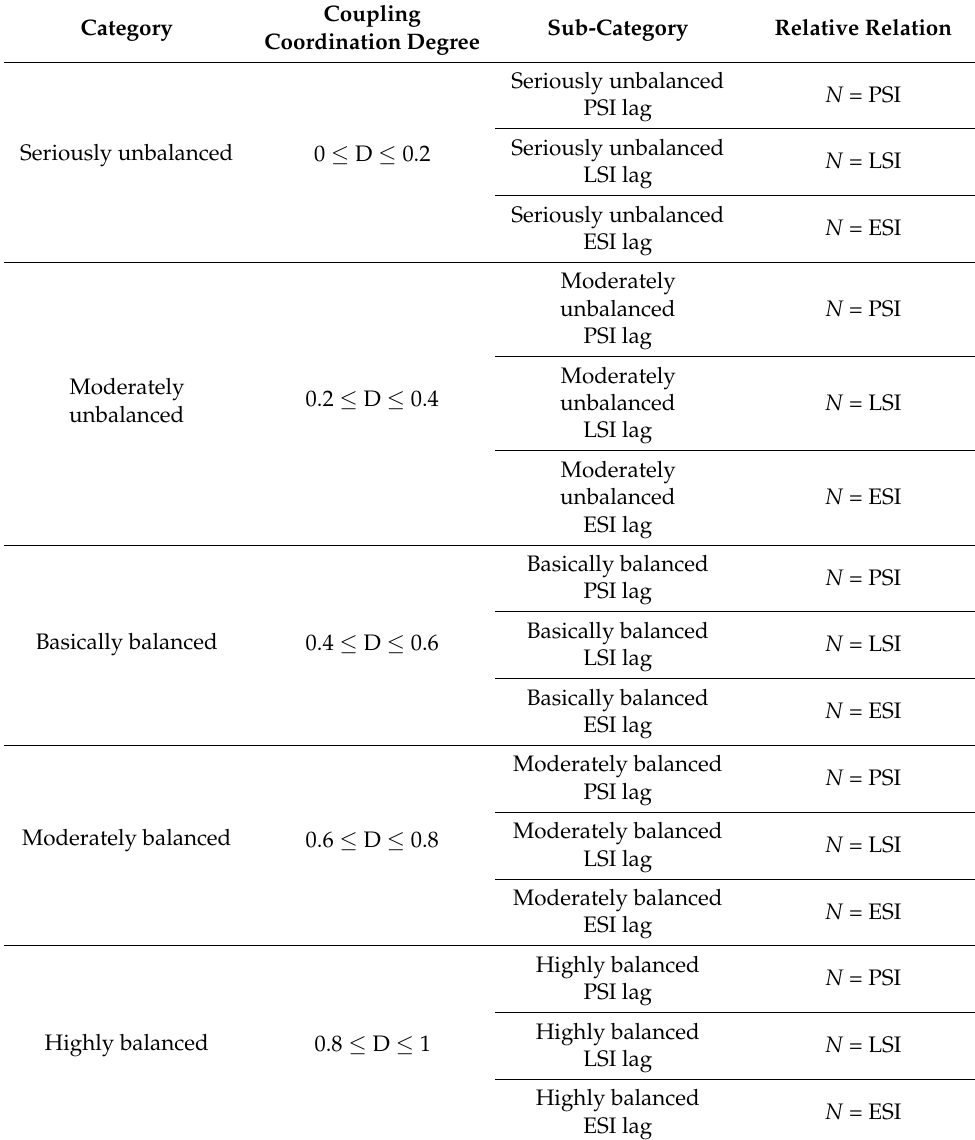
Table 2. Classification of coupling coordination degree of